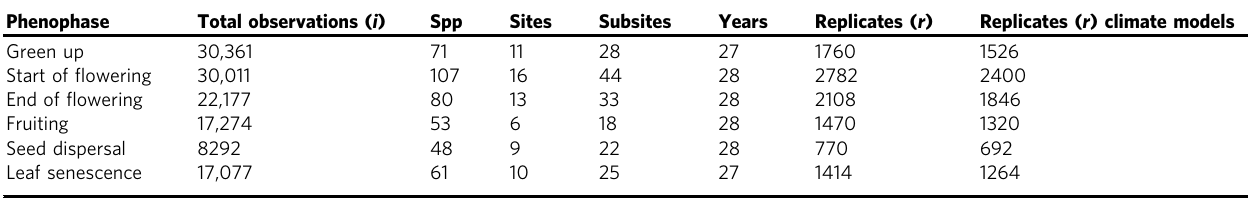
Table 3 Total number of observations, species, sites, subsites, and years, as well as unique species × subsite × year × treatment combinations (replicates) for each of six plant